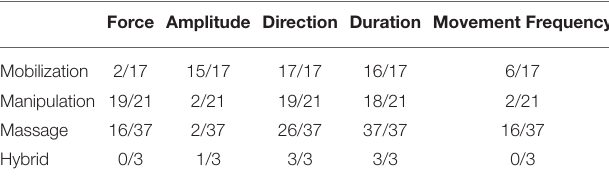
TABLE 2 | Ratio of parameters